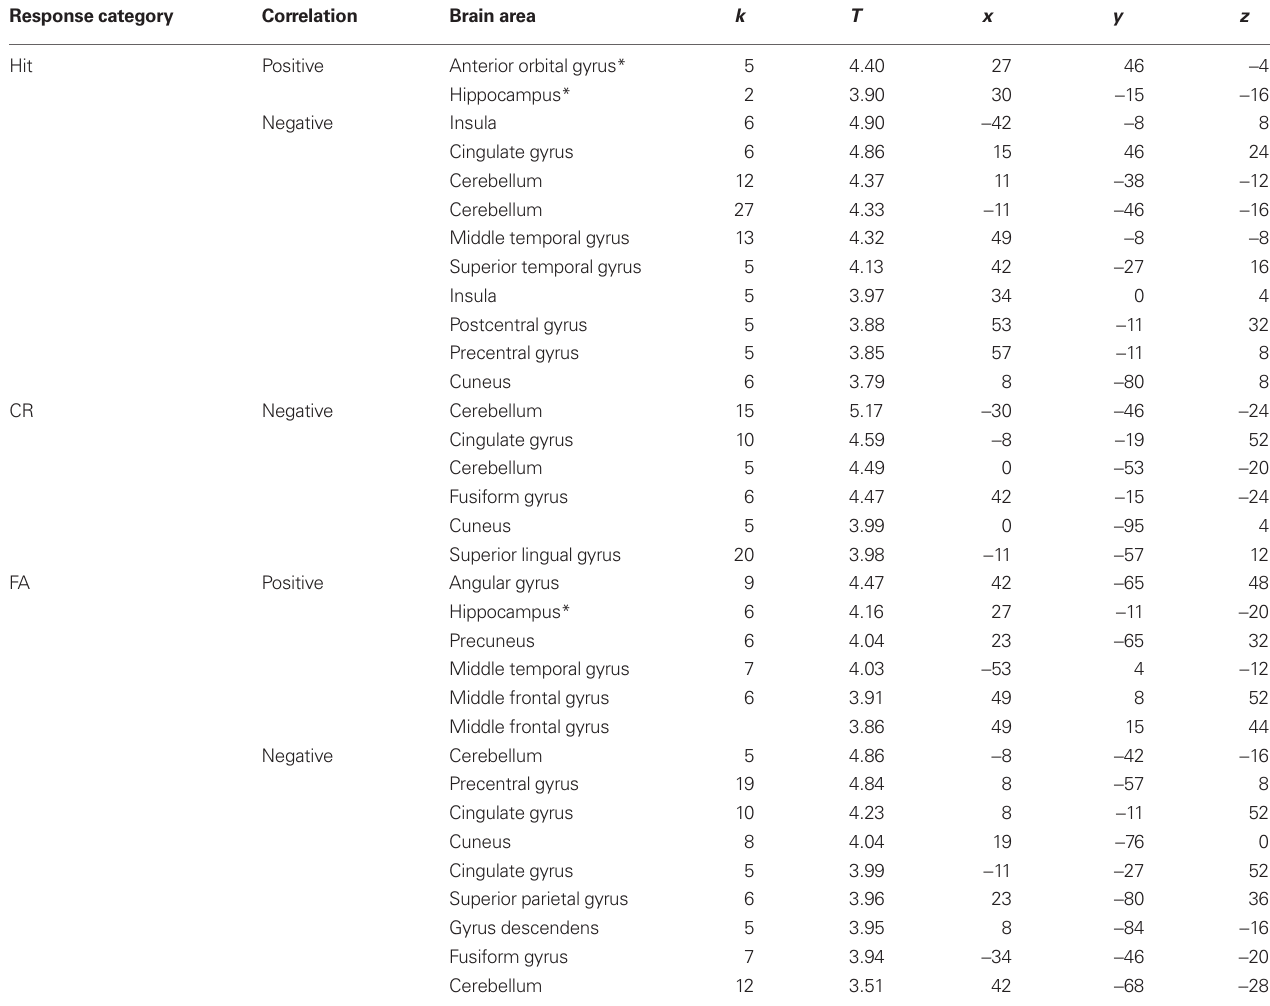
Table 6 | Cerebral areas activated in Hits, Misses, Correct rejections (CR) and false alarms (FA) and associated positively ( + ) or negatively ( − ) with bias